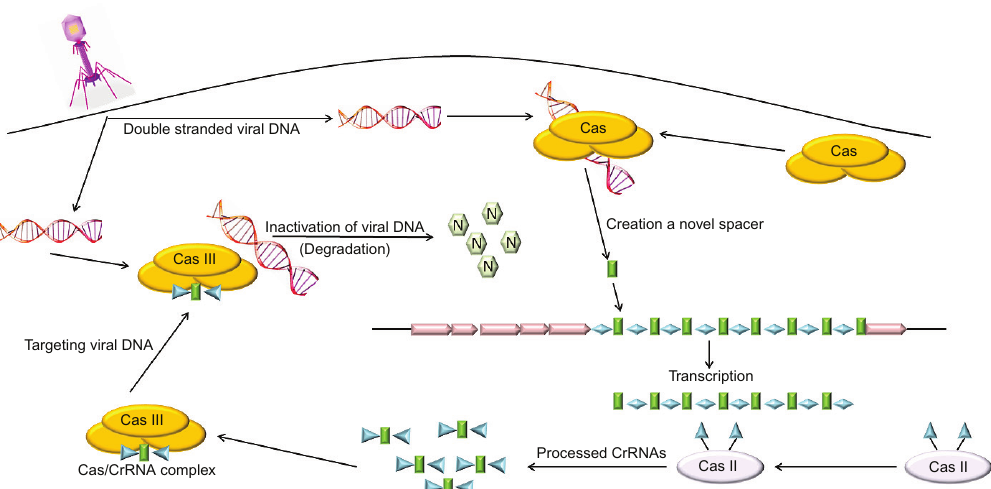
Figure 2. Schematic presentation of clustered regularly interspersed short palindromic repeats (CRISPR/Cas9) system. It is basically a bacterial adaptive immune system. When an exogenous viral or bacteriophage genome is inserted into a bacterium, CAS protein, which acts as a nuclease, detects the exogenous unmethylated genome by attachment to a 3 – 5 nucleotide sequence. Then, CAS protein cuts the target sequence and inserts the fragment just before 3 – 5 nucleotide sequence into host genome. After transcription, crispr RNAs (crRNAs) are produced which are complementary to the exogenous genome. crRNAs can recognize the exogenous genome if a viral reinfection